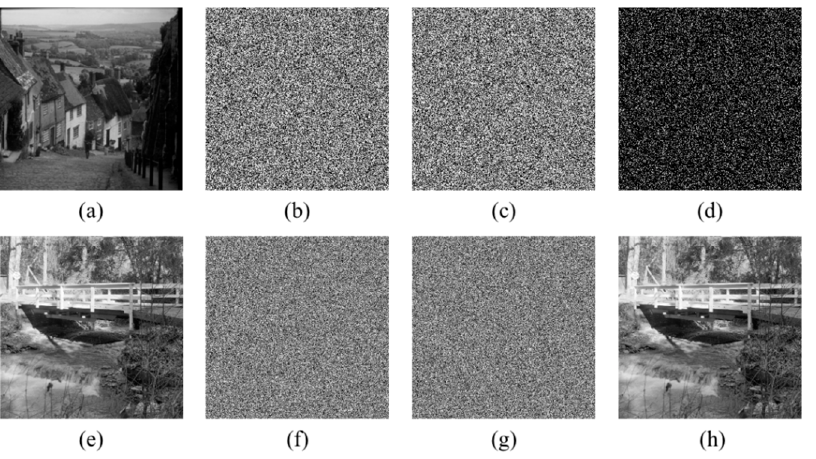
Figure 8. ( a ) Goldhill (256 × 256). ( b ) Cipher using original key. ( c ) Cipher using changed key. ( d ) Difference between ( b , c ). ( e ) Bridge (512 × 512). ( f ) Encryption results of ( e ). ( g ) Decryption